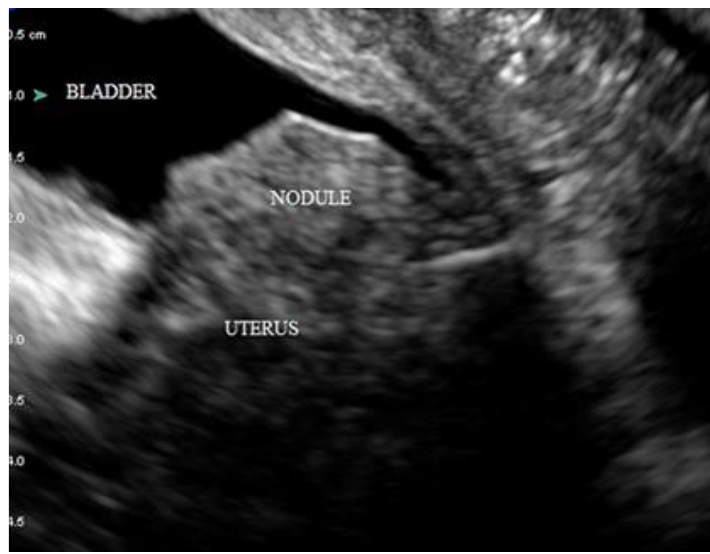
Figure 4. Deep infiltrating endometriosis (DIE) nodule of the bladder appearing as a protrusive nodule arising from the bladder base towards the lumen of the bladder.